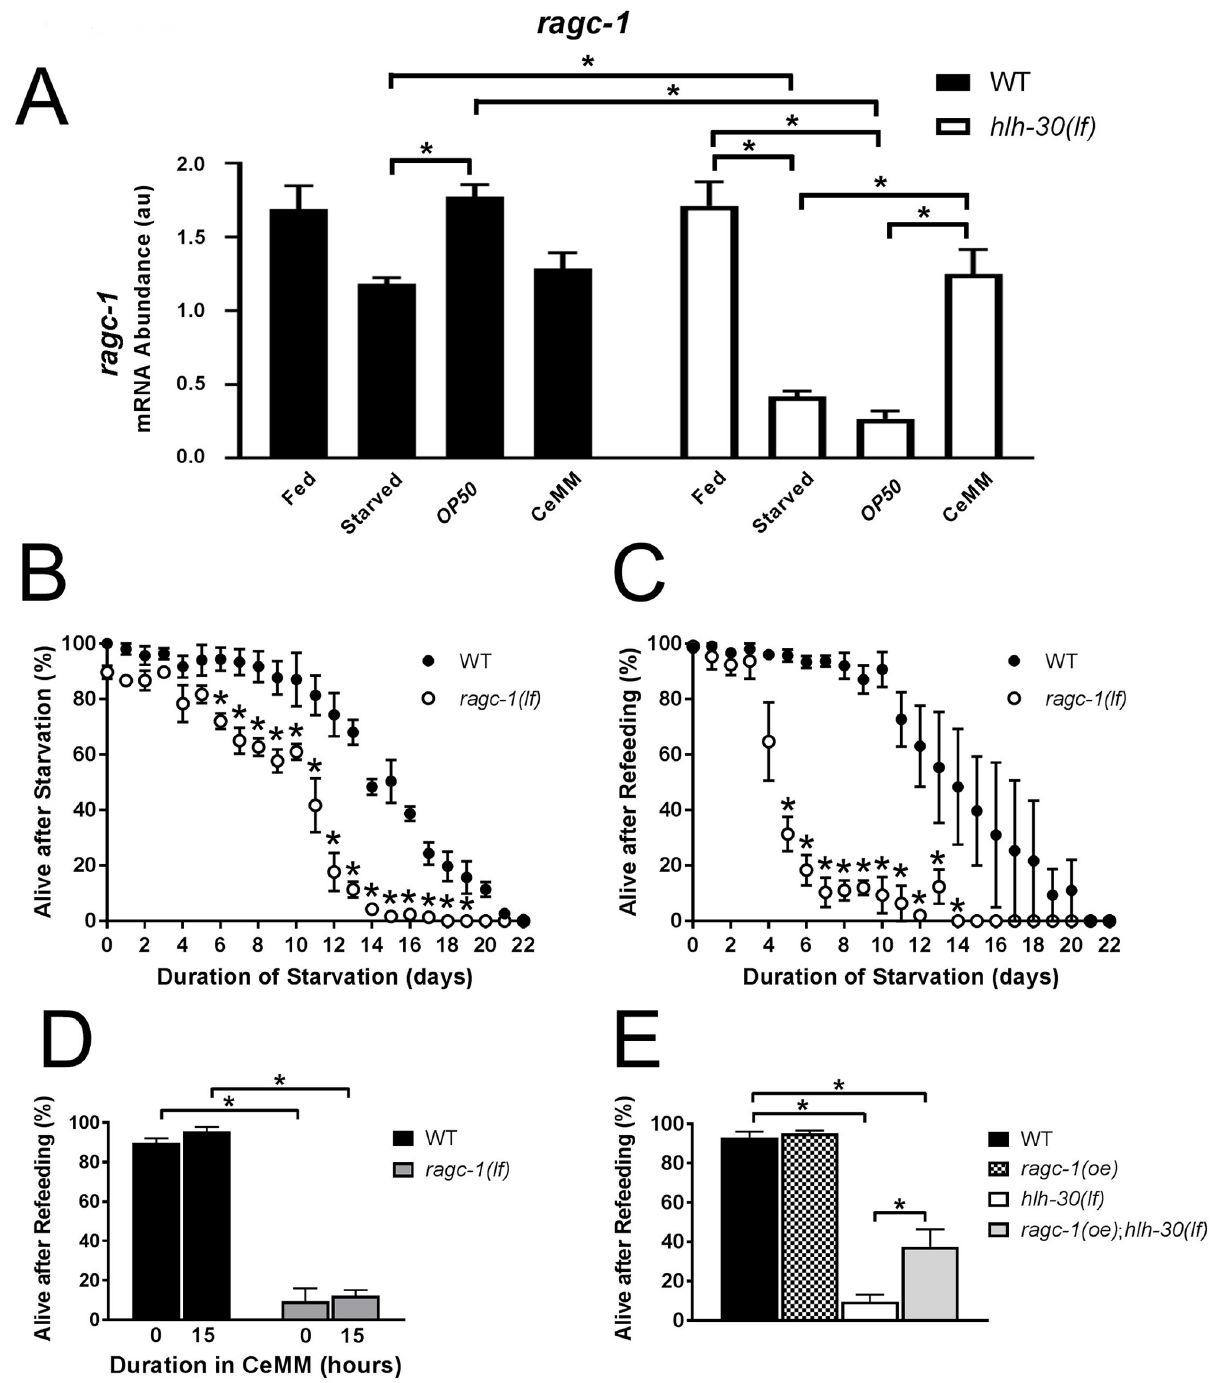
Fig 7. ragc-1 –deficient worms were sensitive to starvation–refeeding stress, and ragc-1 overexpression rescued hlh-30(lf) . (A) ragc-1 mRNA abundance in au with values normalized to the control gene ama-1 determined by qPCR in L1 stage WT and hlh-30(lf) animals in the fed state (fed), after starvation for 33 hours (starved), and after starvation for 33 hours followed by refeeding on E . coli OP50 or CeMM for 15 hours. N = 6 biological replicates/group. � P < 0.05 by post hoc test after two-way ANOVA. (B, C) WT and ragc-1(lf) worms were analyzed for “Alive after Starvation” (B) and “Alive after Refeeding” (C) as described in the legend for Fig 1A. N = 3 biological replicates with approximately 50 worms/time point. � P < 0.05 by post hoc test after two-way ANOVA. (D) WT and ragc-1(lf) L1 stage worms were starved for 11 days and transferred to CeMM for 0 or 15 hours, followed by transfer to E . coli OP50 -seeded NGM dishes for 48 hours. “Alive after Refeeding” was determined as described in the Fig 1 legend. N = 3 biological replicates/group with approximately 50 worms/time point. � P < 0.05 by post hoc test after two-way ANOVA. (E) “Alive after Refeeding” was measured